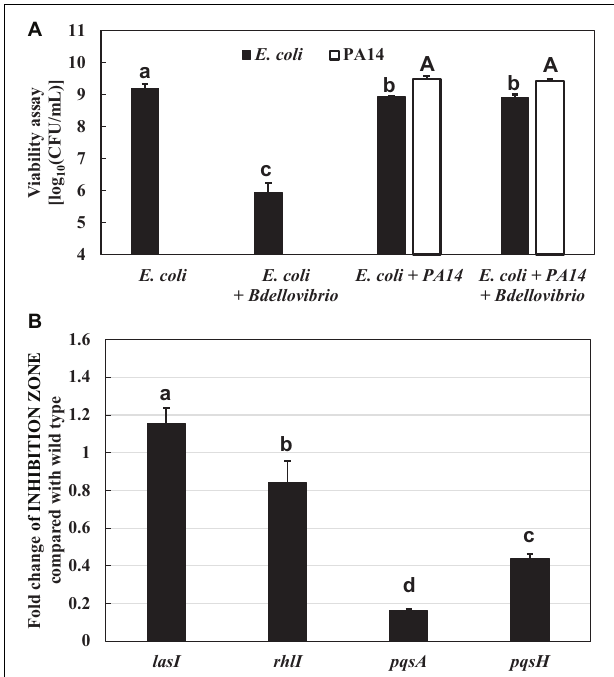
FIGURE 1 | Inhibition of the predatory activity of Bdellovibrio bacteriovorus in the presence of Pseudomonas aeruginosa . (A) Dynamics of viable cells of Escherichia coli or/and P. aeruginosa PA14 with or without B. bacteriovorus 109J. Each cell suspension (initial cell turbidity was adjusted to be ∼ 2 at OD 600 ) in HEPES buffer was incubated for 72 h at 30 ◦ C and 120 rpm under aerobic condition ( n = 2). (B) Effect of P. aeruginosa quorum-sensing mutants ( las , rhl , and pqs ) on the predation plate assays using a mixture of B. bacteriovorus 109J and E. coli BW25113. In the plate assays using E. coli BW25113 as a prey cell, the area of the inhibition zone was compared in the presence of each P. aeruginosa strain ( P. aeruginosa wild type, lasI mutant, rhlI mutant, pqsA mutant, or pqsH mutant), n = 3. The value among each sample with different letters is significantly different ( p < 0.05).